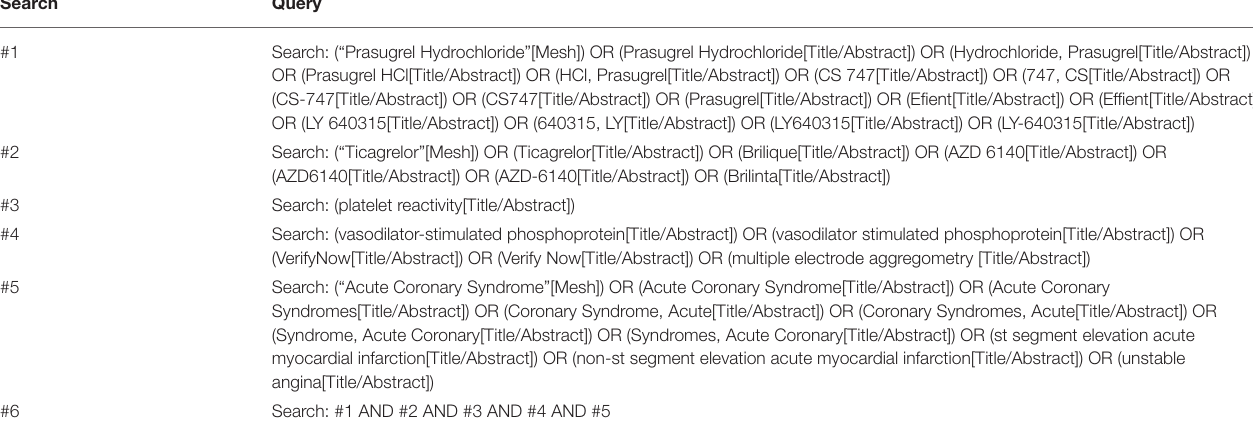
TABLE 1 | PubMed search strategy.